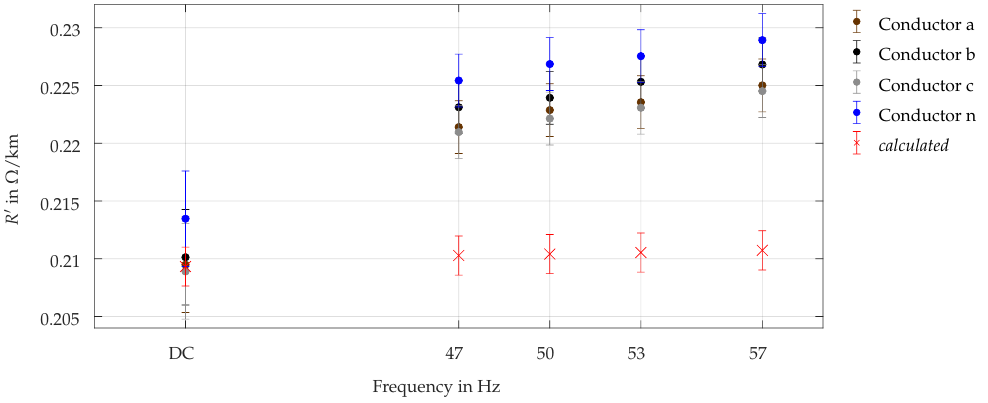
Figure 13. Calculated and measured resistances at ϑ = 24 ± 2°C (NAYY-J 4 × 150 SE, cable A